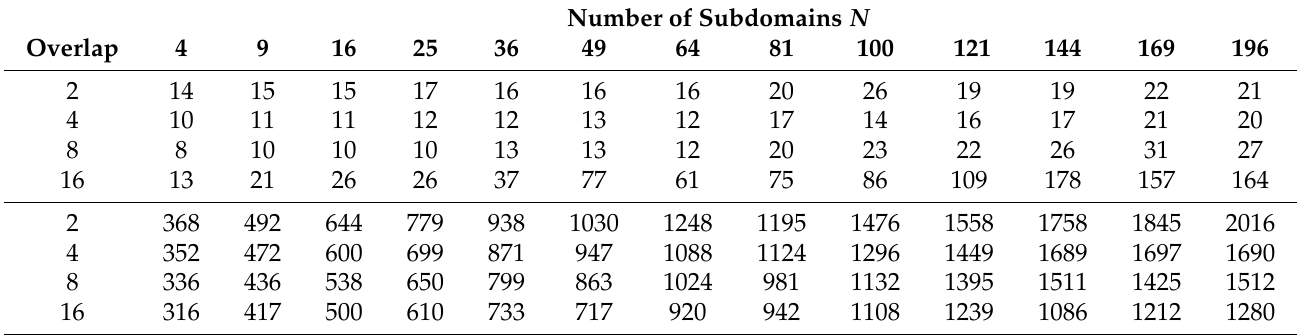
Table 10. Preconditioned GMRES iteration counts (above) and size of coarse space (below) for the homogeneous problem when using ORAS with H-GenEO, varying the amount of overlap (in terms of element width, with 2 representing minimal overlap) and number of subdomains for k = 46.5 and